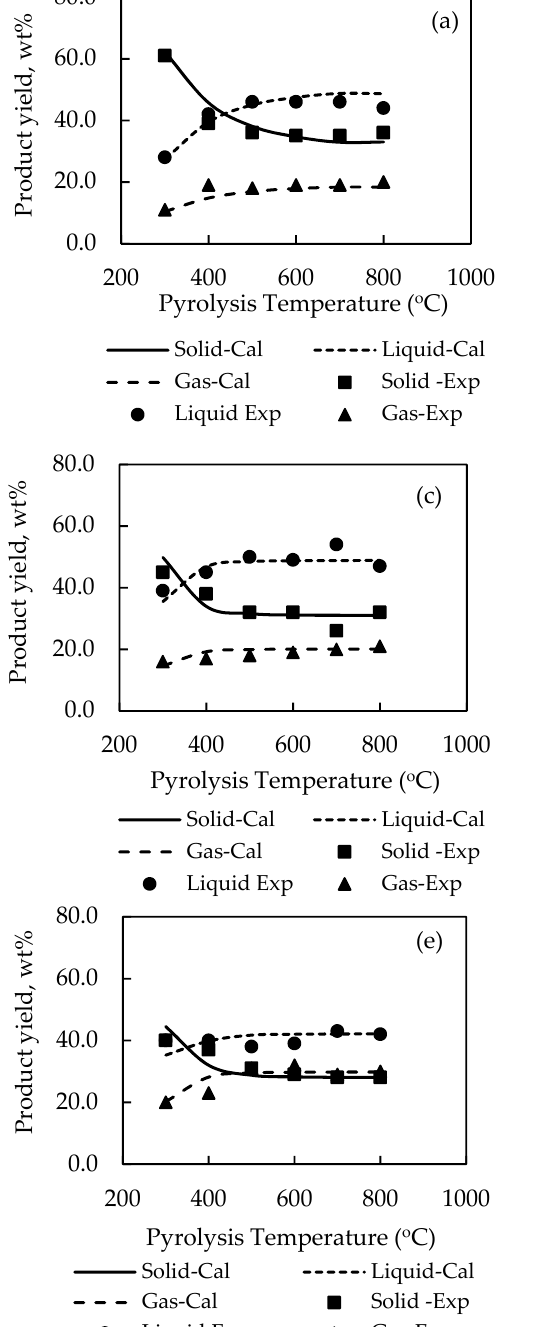
Figure 2. Comparison of experimental and simulated pyrolysis product yields as a function of pyrolysis temperature for ( a ) palm shell (PS), ( b ) coconut shell (CS), ( c ) palm kernel cake (PK), ( d ) longan fruit seed (LS) and ( e ) cassava pulp residue (CP), using pyrolysis models P01–P05 .